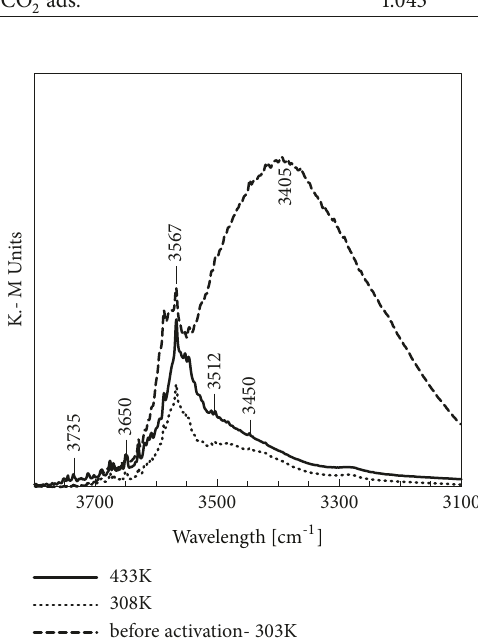
Table 4: Diffusion parameters of proton mobility in Z5A-1 before and after adsorption carbon dioxide at 433 K. Γ 2 [˚A 2 ] 𝜏 Before CO 2 ads.